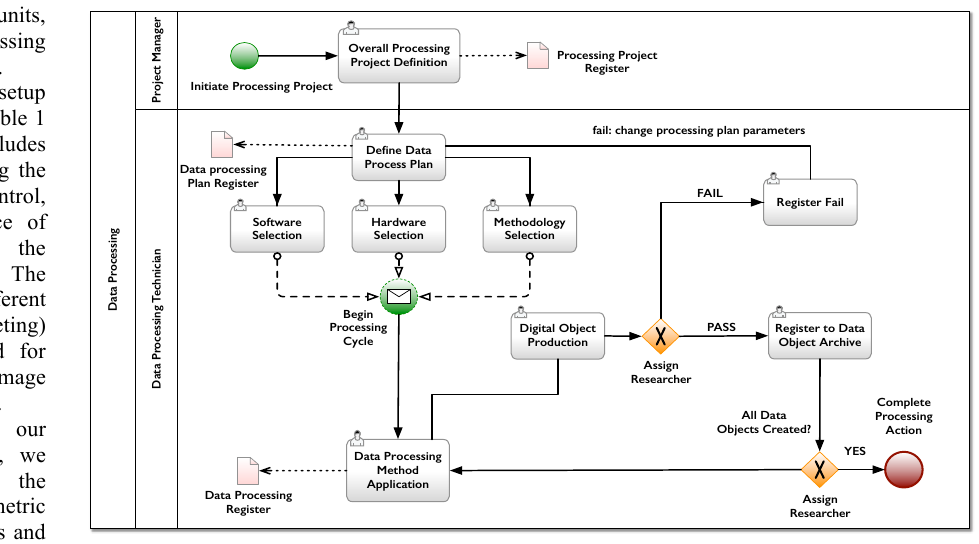
Figure 4. BDP: Step